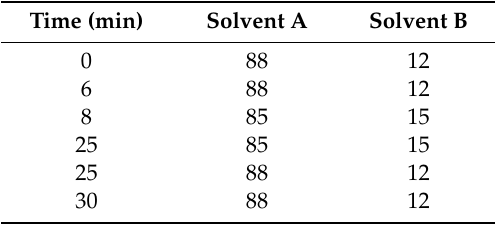
Table 2. Solvent system of the anthocyanins using HPLC